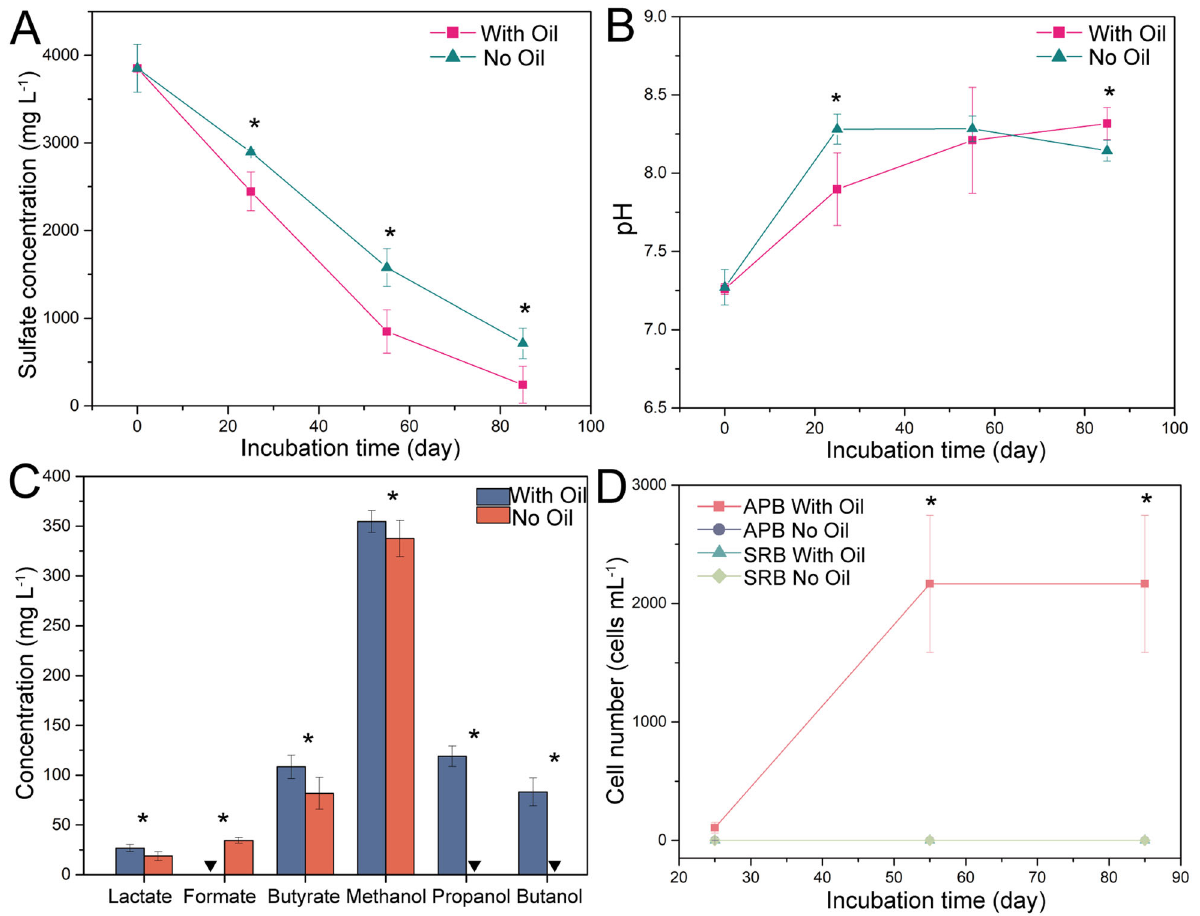
Fig. 1 Changes of major geochemical factors of seawater during different culture stages (25, 55, and 85 days) with/without crude oil exposure. Changes of A sulfate concentration in seawater and B pH value along with incubation time. C The concentration of low-molecular organic acids and alcohols after 85 days of incubation. D Cell number of acid-producing bacteria (APB) and sulfate-reducing bacteria (SRB) calculated using MPN enumeration methods. “ * ” indicated the signi fi cant differences between groups by t -tests; “ ▾ ” indicated the undetected substances. “ With Oil ” : With crude oil amendment; “ No Oil ” : Without crude oil. T1: 25 days; T2: 55 days; T3: 85 days. Error bars represent standard deviations of three independent samples from triplicate systems.